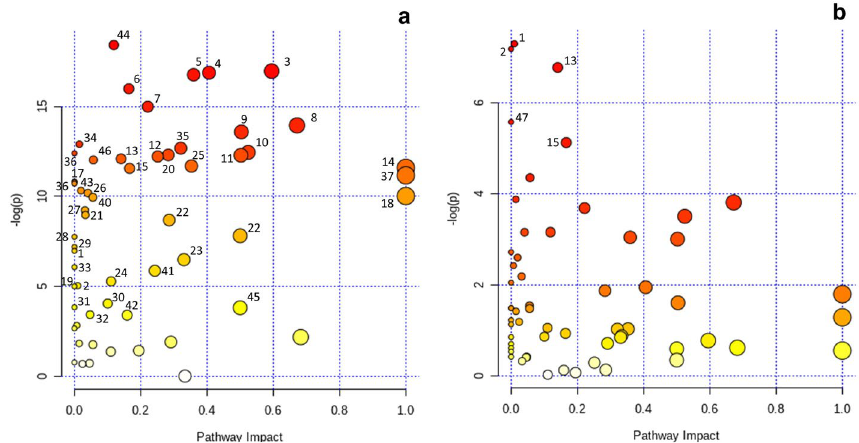
Figure 3. Metabolic pathway análisis based on metabolic enrichment analysis and topologic analysis of metabolomic profiles comparing metabolic pathways shifts when comparing: ( a ) 21 vs. 180 days in milk, or ( b ) North American vs. New Zealand Holstein at 21 days in milk. Increasingly red colors indicate lower P -values (more significant shift in the pathway), greater circle size indicate greater pathway impact.